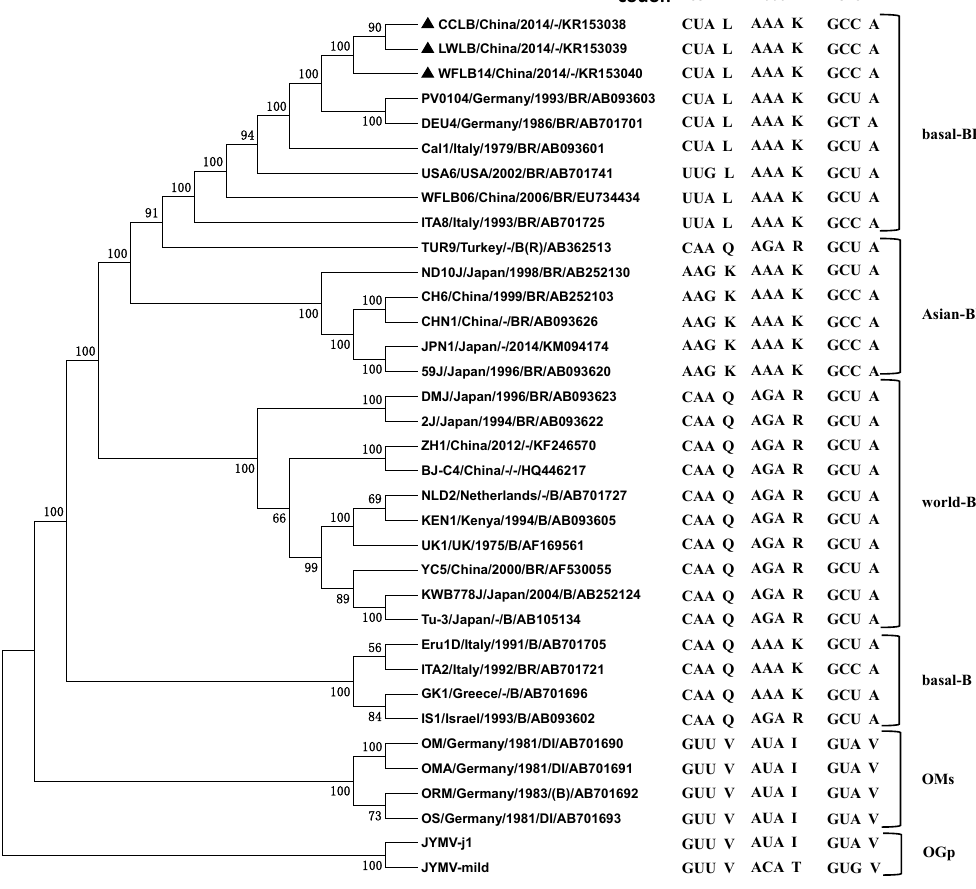
Figure 2. A maximum likelihood tree showing the relationships inferred from the complete genome sequences of 33 viruses of the TuMV group, together with those of isolates of JYMV as an outgroup (OGp). The branches are horizontal and show, for each genome, the codons at sites 852, 1006 and 1548, numbered as in the alignment used. Bootstrap values (%) more than 60 are listed; nodes with <50% bootstrap support have been collapsed. Isolates are indicated in the tree by isolate name/geographical origin/origin of host/pathotype. “-“ indicates the corresponding information is not available.